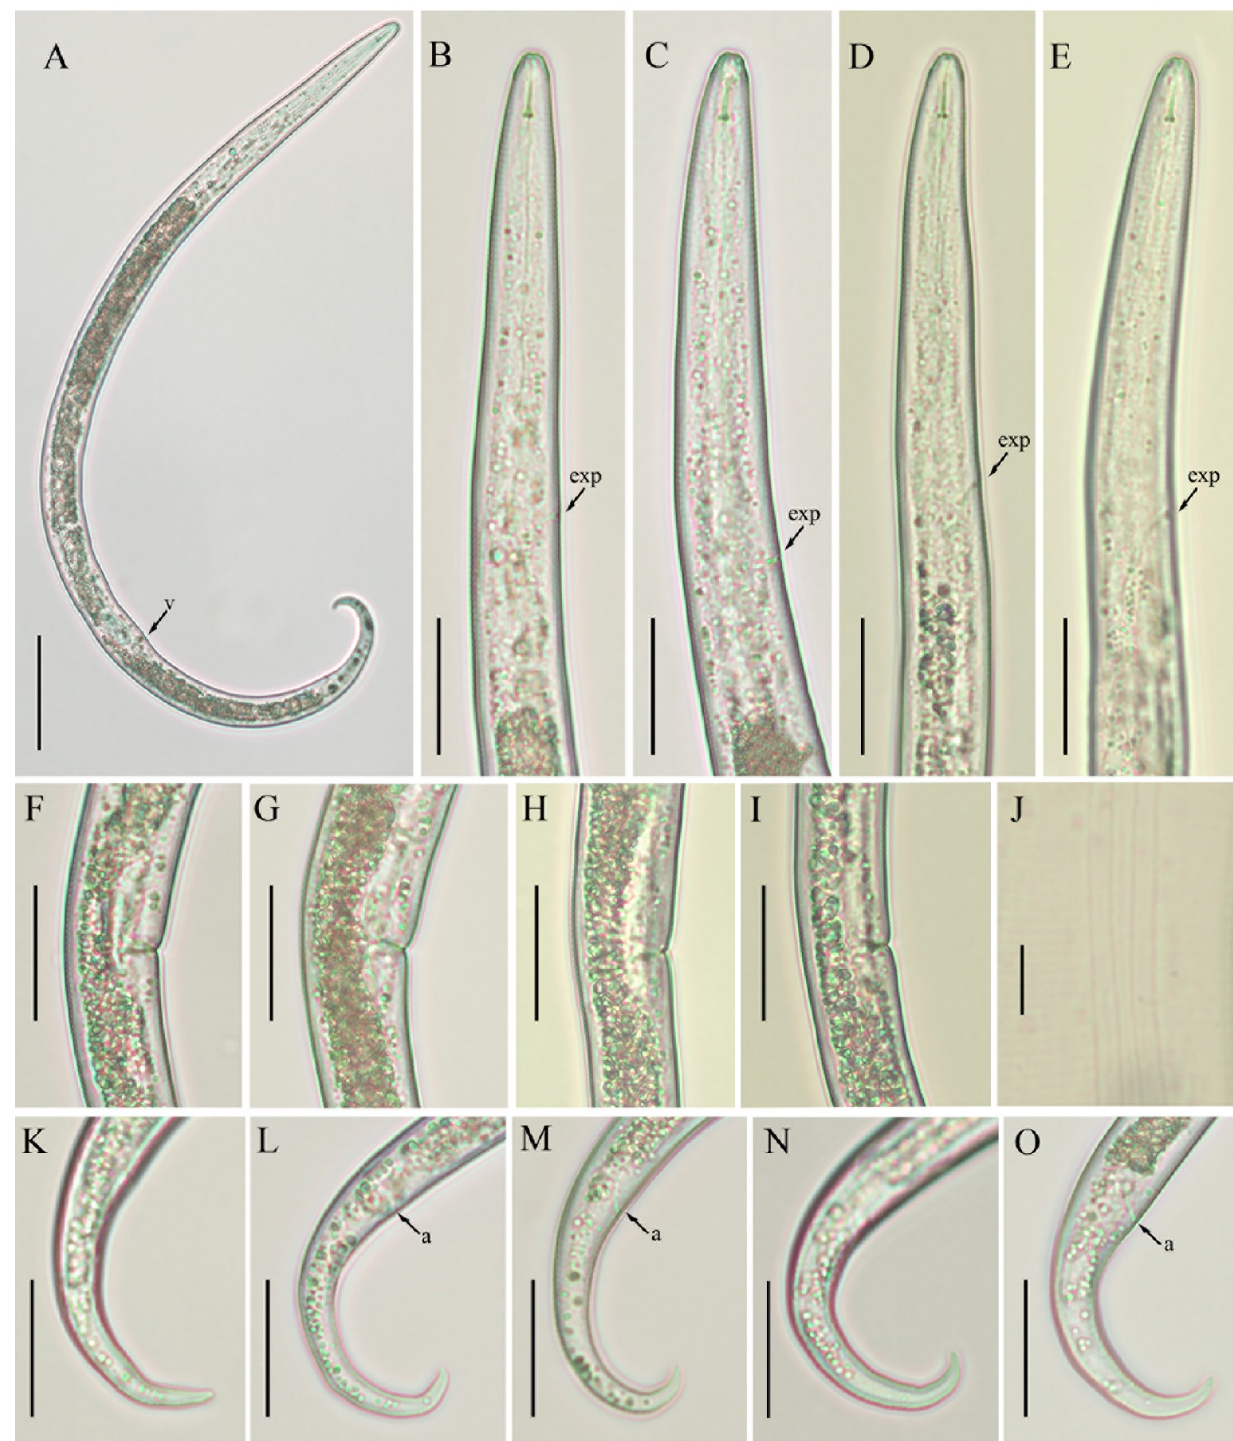
Figure 4. Photomicrographs of Boleodorus volutus female, Canadian populations 61 and 40. ( A ) Entire body, population 61; ( B , C ; D , E ) pharyngeal region of populations 61 and 40, respectively; ( F , G ; H , I ) vulval regions of populations 61 and 40, respectively; ( J ) lateral lines; ( K – M ; N , O ) tail regions of populations 61 and 40, respectively. Scale bars: ( A ) 50 µm; ( B – I , K – O ) 20 µm; ( J ) 5 µm. Arrowheads: (a) anus; (exp) excretory pore; (v) vulva.